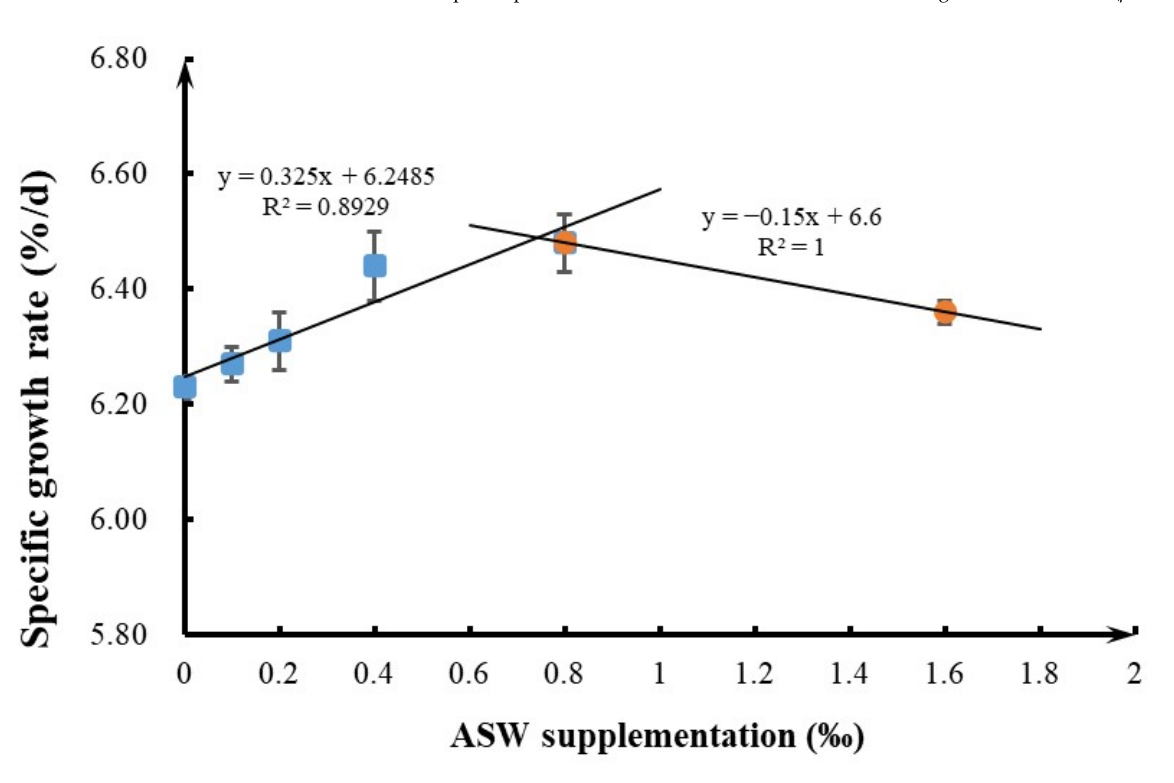
Table 3. Effect of ASW on growth performance of GIFT (mean ± SEM).